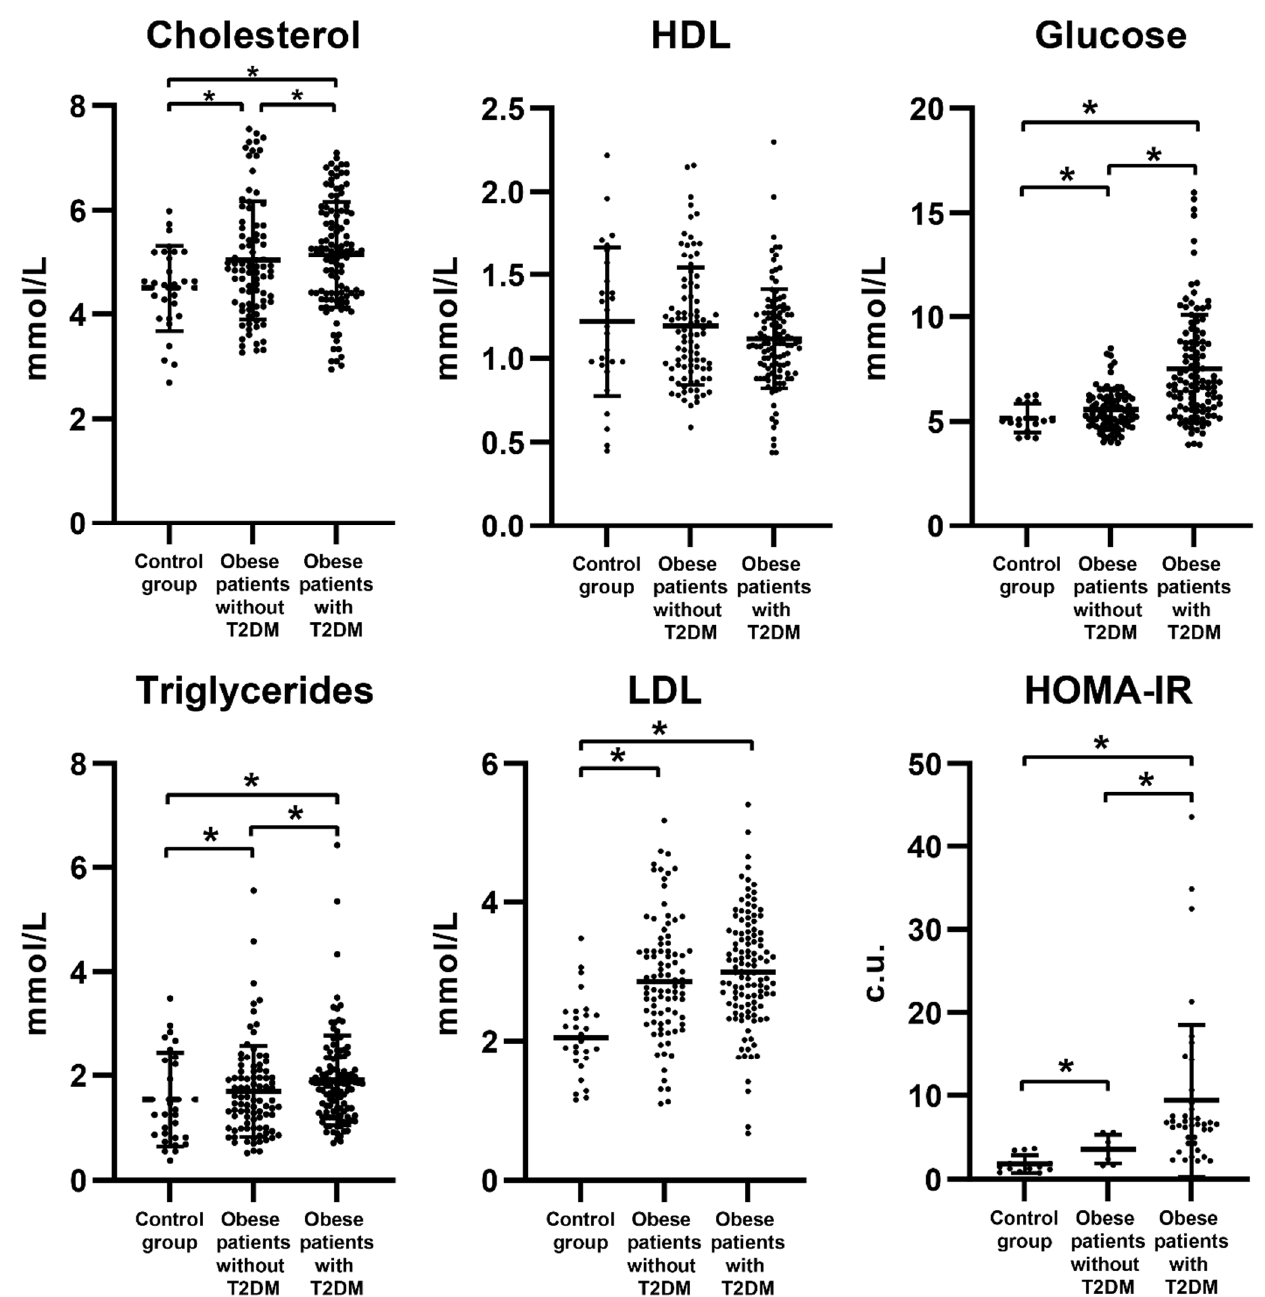
Figure 1. Biochemical parameters of carbohydrate and lipid metabolism in obese patients with and without T2DM. *— p < 0.05 the significance is determined using the Mann–Whitney criterion for two independent samples. HOMA-IR—insulin resistance index.